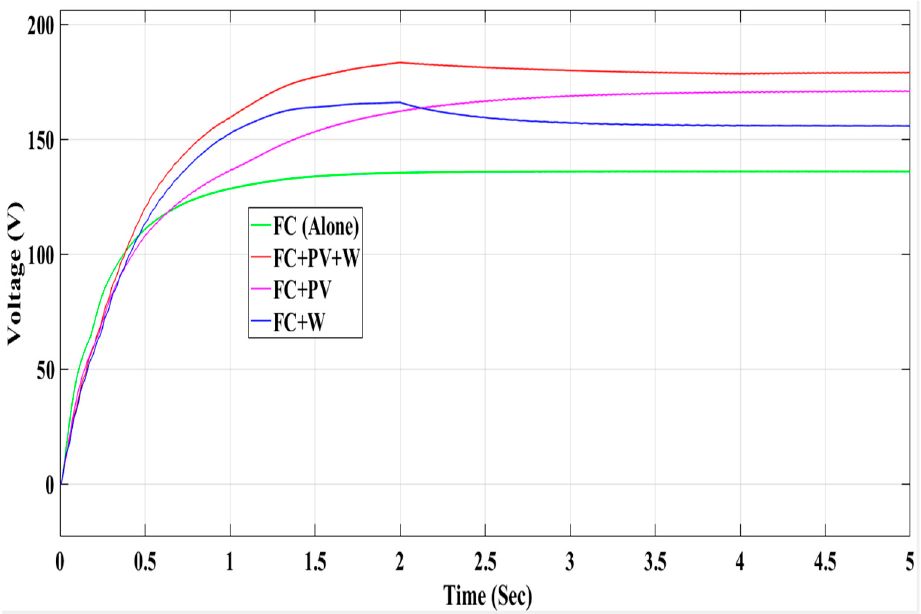
Figure 34. Comparative characteristics of voltage in the FC, FC–PV, FC–W and FC–PV–W models using a fuzzy logic controller.